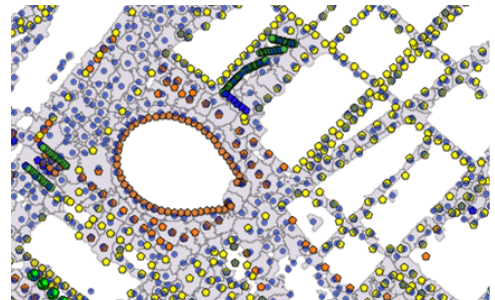
Figure 4. Detection of spot source lights and their illuminated neighbourhood.